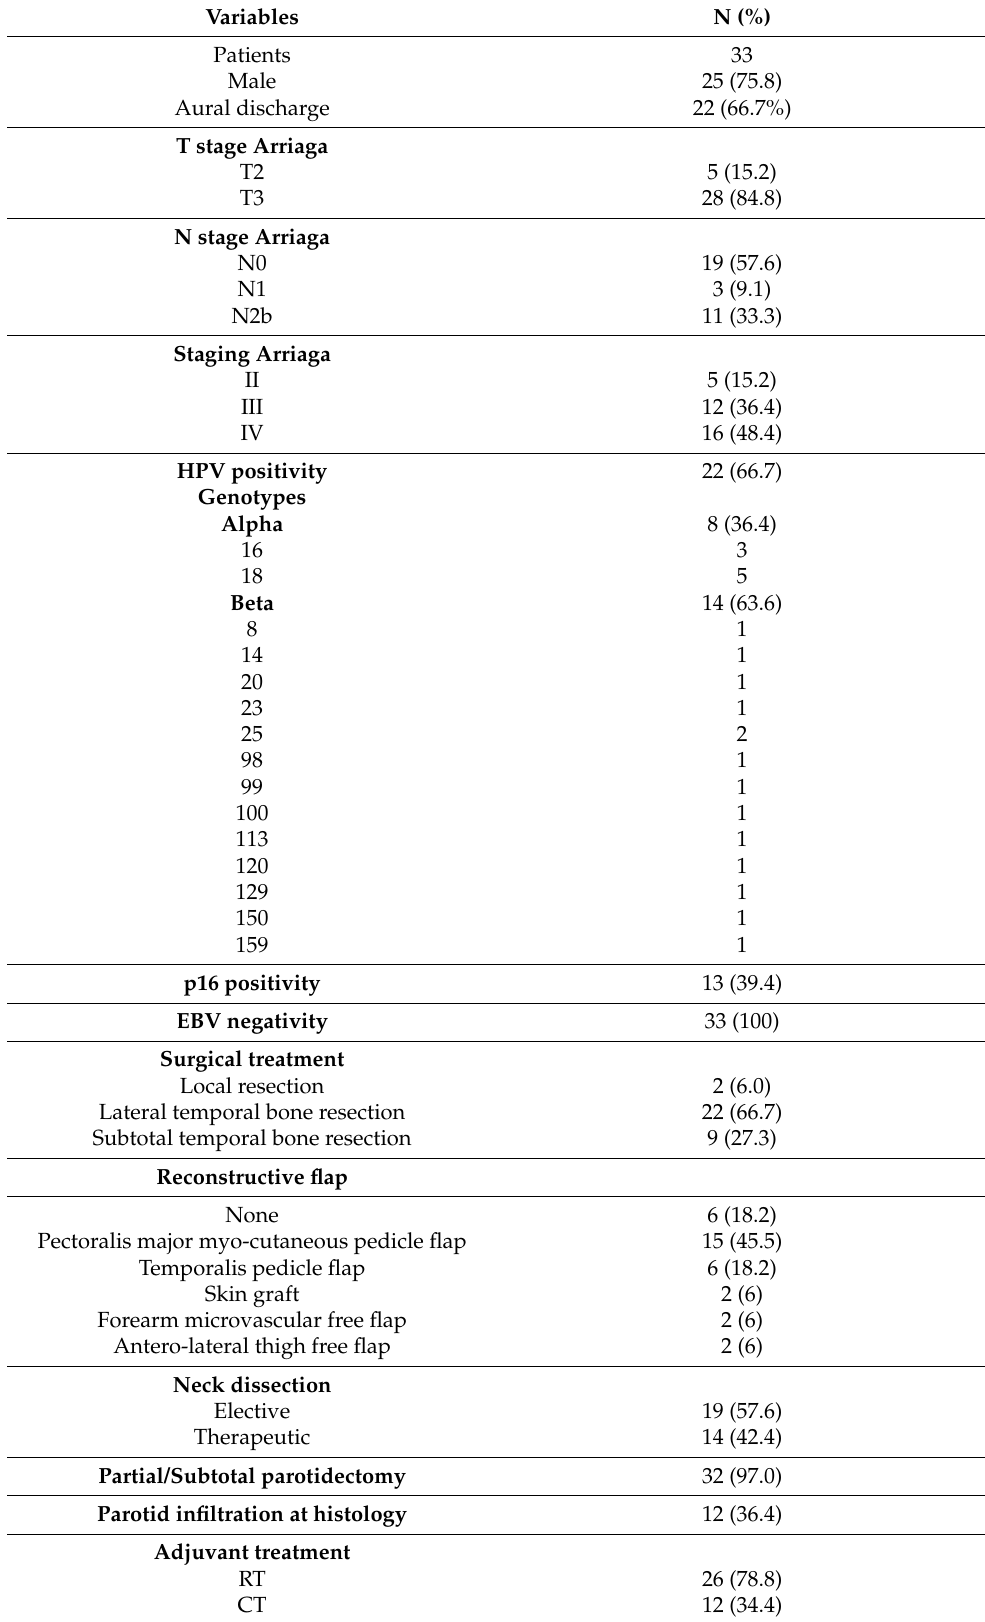
Table 1. Patients demographics, tumor and treatment